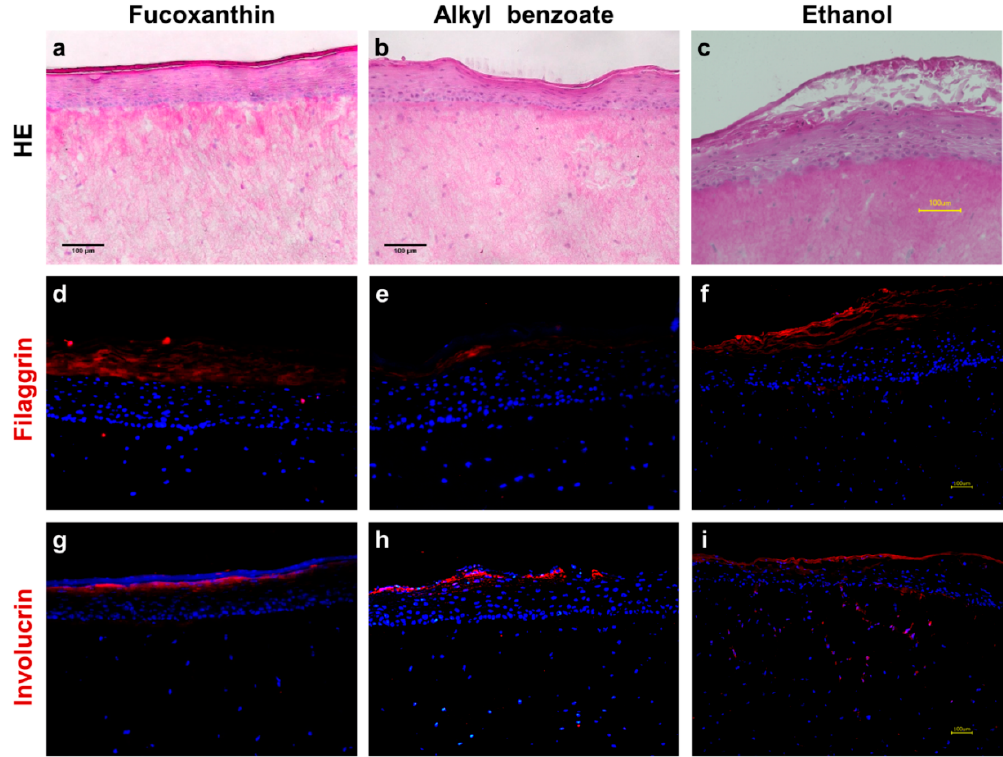
Figure 2. Morphology and protein expression in reconstructed human skin following fucoxanthin exposure versus the vehicles alone. ( a – c ) Hematoxylin-eosin staining with slightly disturbed morphology in c. ( d – f ) Immunolocalization of filaggrin with enhanced expression in d and f. ( g – i ) Similar immunolocalization of involucrin in all samples. Images are representative of at least three batches; nuclei in blue (DAPI); scale bars = 100 μ m.